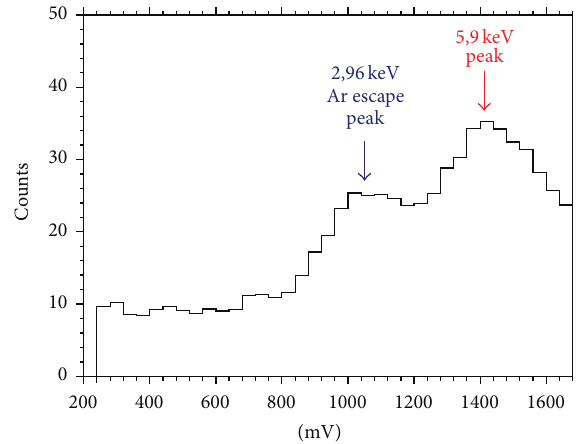
Figure 3: The calibration spectrum from 55 Fe source introduced directly in a working volume of the counter facing first